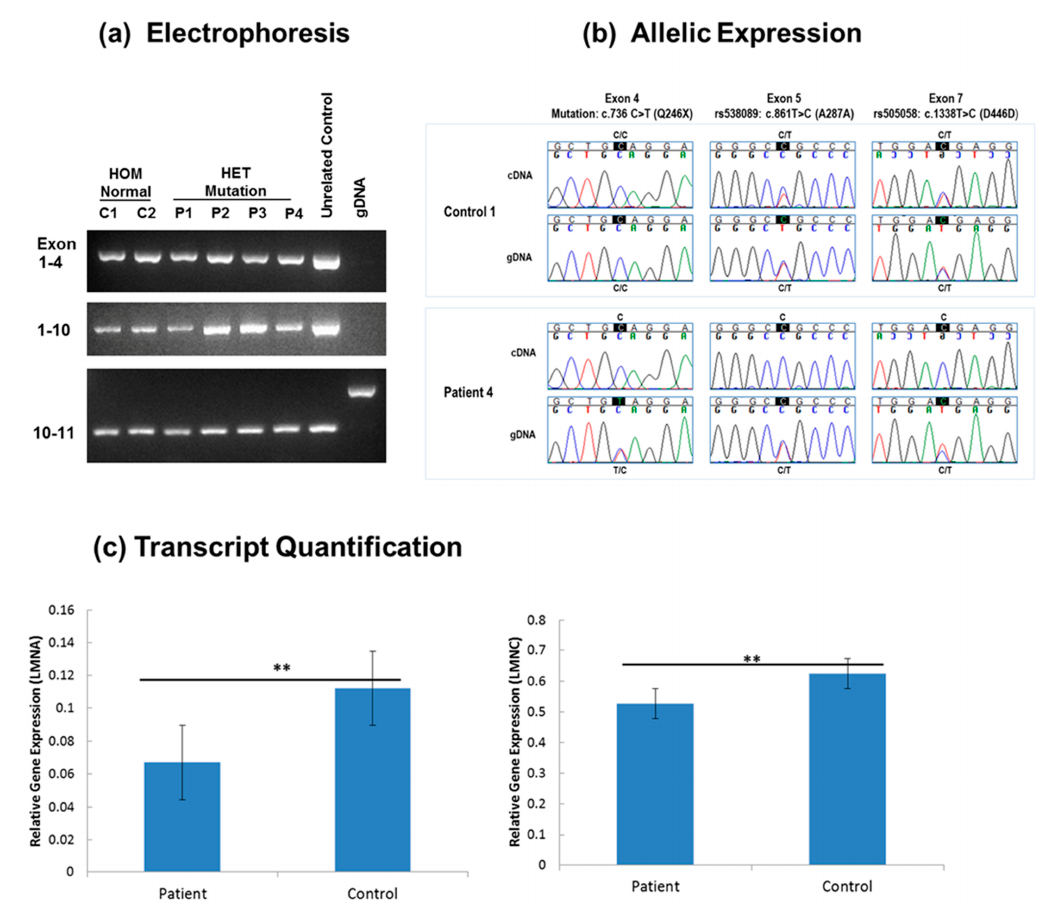
Figure 4. Expression analysis of LMNA in patient and control fibroblasts. ( a ) Electrophoresis: